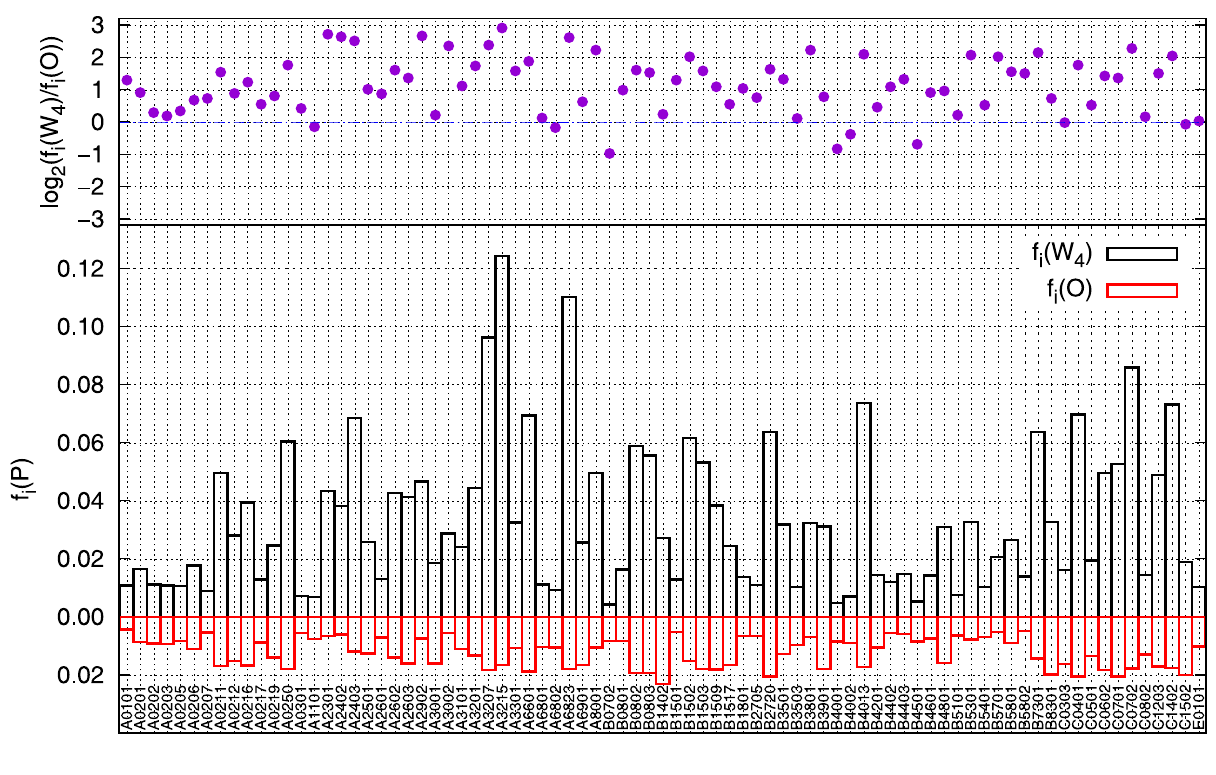
Fig 3. The percentage of strong binding peptides for sets W4 (black bars) and O = W1 U W2 U W3 (red bars) are reported in the lower panel for each HLA considered in the present paper. The graph shows that in the W4 set there are a much larger number of strong binding peptides than in the O set. In the upper panel the logarithmic ratio between the two percentages are shown in order to evidentiate the difference in amplitude of the